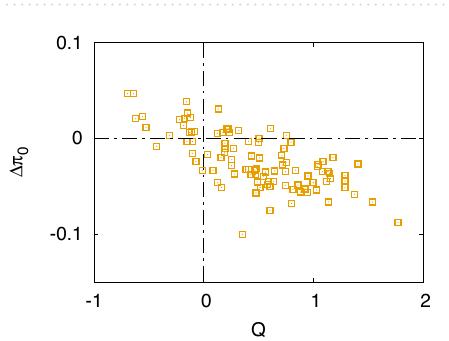
Figure 2. Stationary states of a population with N = 50 players, reached from an initial condition with m ij = 1 for every i and j . In each case, the mutant norm differs from the resident one by δ 1 = 0.02 and occupies one half of the population ( p = 0.5 ). The game is defined by Eq. (1) with b = 2 and c = 1 . ( a ) Average payoffs over 5 × 10 4 samples when the resident norm is Simple Standing. Everyone can observe each interaction with probability q = 0.4 , and perception error and implementation error occur with probabilities e = 0.1 and γ = 0.1 , respectively. Inset: Convergence of payoff difference �π 0 ≡ π 0 − π 1 as M increases. If M ∝ gN with a sufficiently large constant g (cid:31) O ( 10 ) , the mutants will obtain less payoffs than Simple Standing, making �π 0 < 0 . This result has no significant dependence on N . ( b ) Payoff advantage of mutants with respect to the resident as a function of b / c , averaged over 5 × 10 4 samples per each, when M = 10 4 . The resident norm, a variant of Simple Standing, has α( 1, 1, 1 ) = β( 1, 1 ) = 1 and A x = A z = B x = 0 but A y = B y = 0.9 as in Fig. 1. Implementation error occurs with probability γ = 0.1 , and the results are qualitatively the same for any small γ . The stars on the horizontal line indicate the predicted threshold values obtained from the first-order and second-order calculations, respectively. In both of these panels, the shaded areas represent error bars.